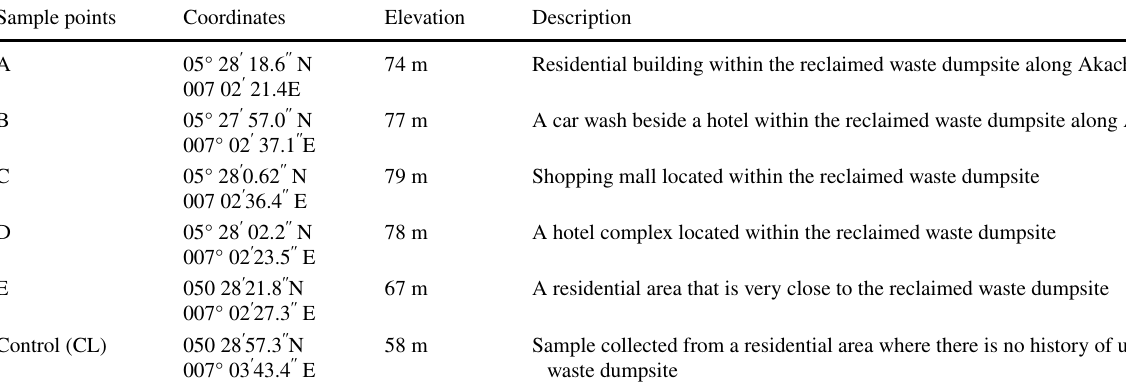
Table 1 The coordinates and description of the borehole water sample points Sample